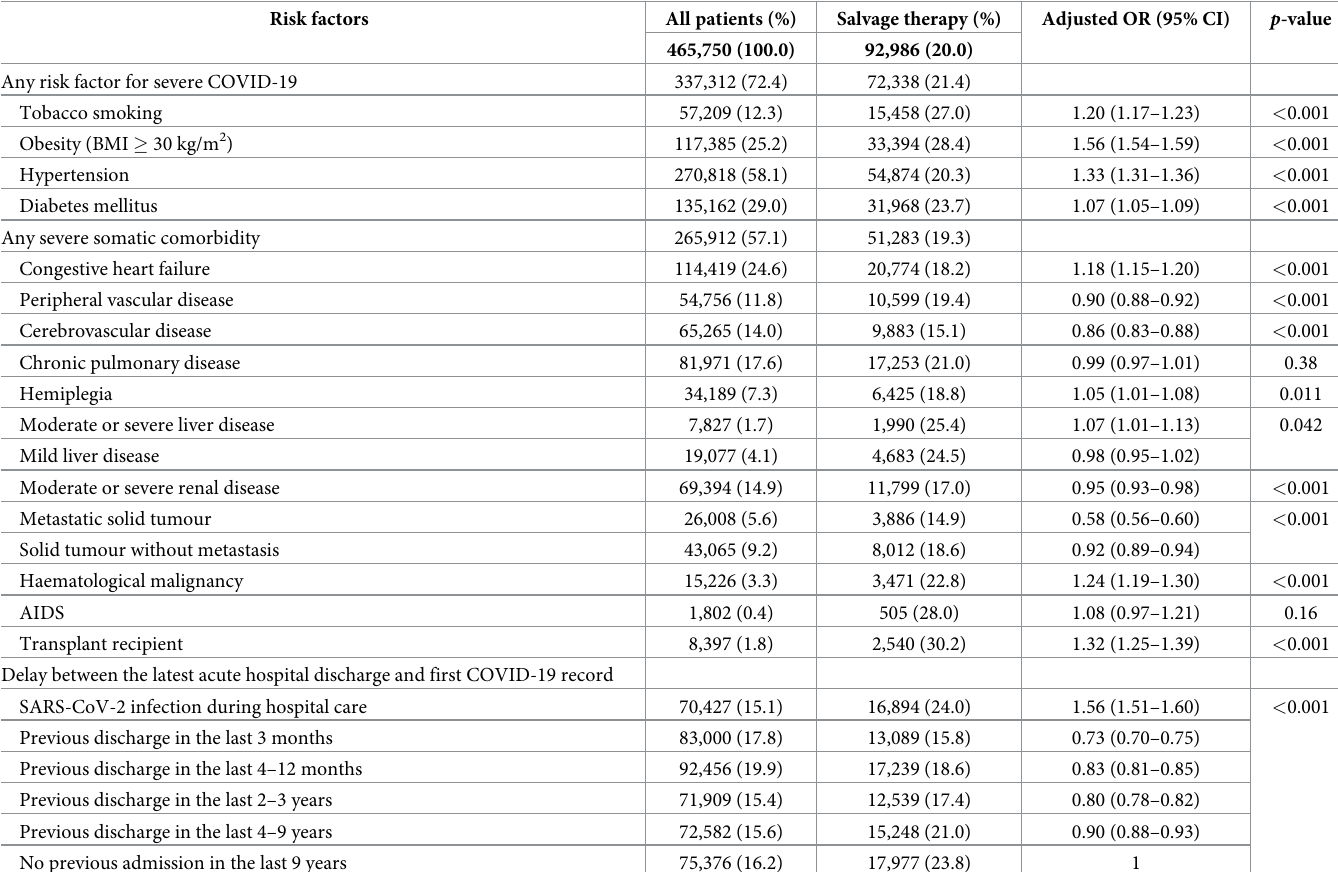
In subgroup analyses on age category, differences in excess mortality risks between patients with and without mental disorders were more marked in patients aged 18 to 64 years (42.3% alcohol use disorders) (+5.5% [95% CI, 4.7 to 6.3] versus +1.1% [95% CI, 0.8 to 1.3] for pre- dicted risks of 8.3% [95% CI, 7.9 to 8.6] and 3.8% [95% CI, 3.7 to 3.9] at baseline, respectively) compared to patients older than 65 years (54.4% dementia) (+10.1% [95% CI, 9.6 to 10.7] ver- sus +8.0% [95% CI, 7.5 to 8.4] for predicted risks of 24.9% [95% CI, 24.7 to 25.1] and 20.1% [95% CI, 20.0 to 20.3] at baseline, respectively) ( Figs A and B in S1 Text ). A similar analysis was carried on access to salvage therapy ( Fig 3 ). Patients without mental disorders accessed salvage therapy at significantly higher rates than expected, with increasing rates over the study period (overall: +4.2% [95% CI, 3.8 to 4.5] for a predicted rate of 18.8% [95% CI, 18.7 to 18.9] at baseline). In contrast, patients with preexisting mental disorders accessed salvage therapy at significantly lower rates than expected, except in the last 2 pan- demic periods (overall: − 4.1% [95% CI, − 4.4; − 3.7]) for a predicted rate of 18.0% [95% CI, 17.9 to 18.2] at